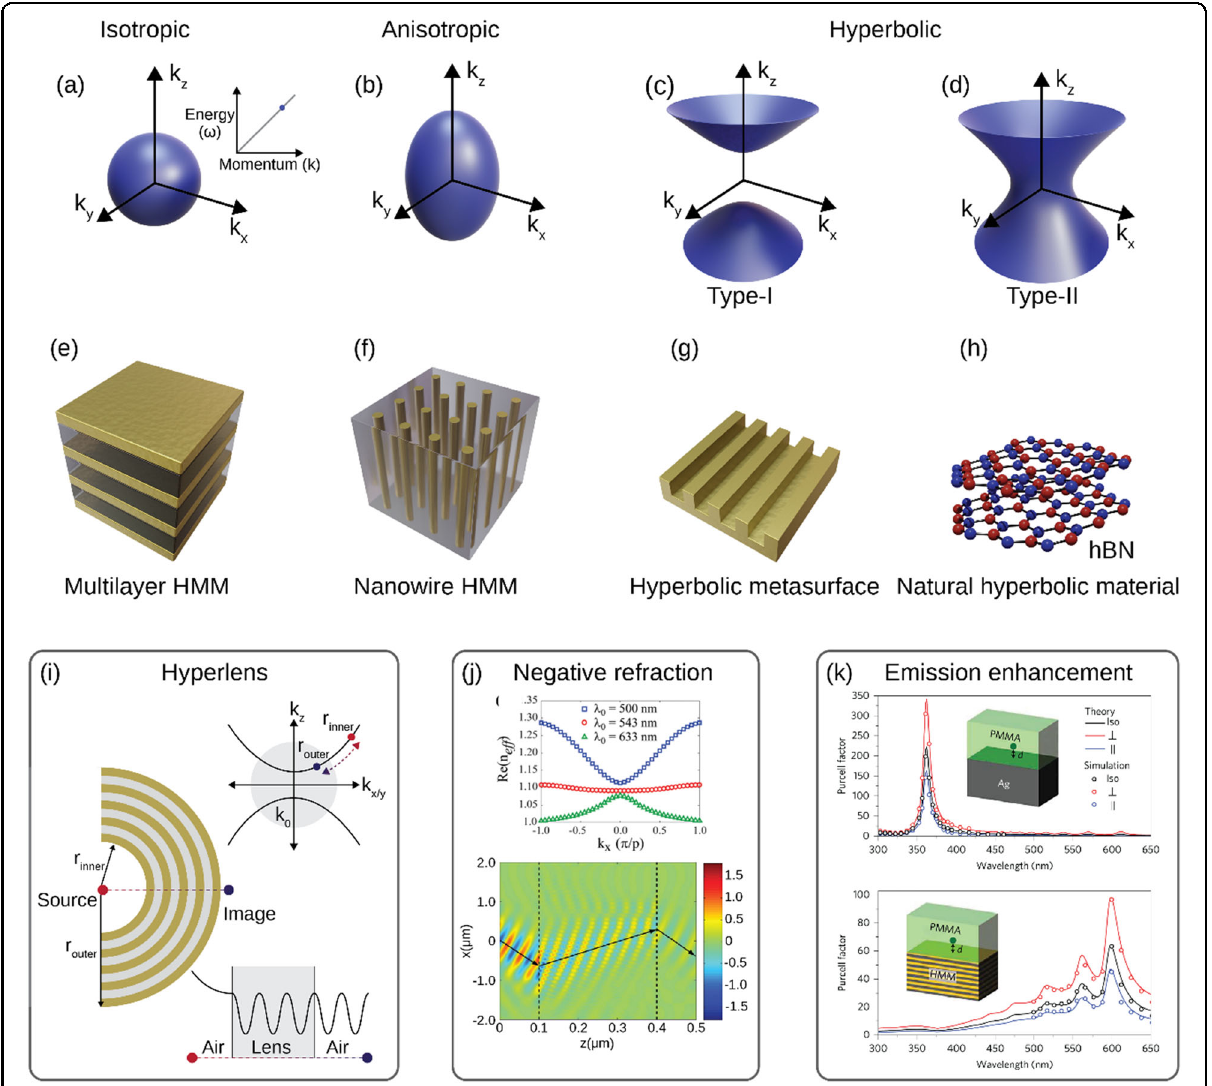
Fig. 1 Principles and applications of hyperbolic metamaterials. Isofrequency contour for a isotropic, b anisotropic media, and c Type-I and d Type-II hyperbolic materials. Different hyperbolic material designs: e multilayer hyperbolic metamaterial (HMM), f nanowire HMM, g hyperbolic metasurface, and h natural hyperbolic material. Different applications of HMMs: i a HMM hyperlens, j negative refraction in a plasmonic grating HMS, and k spontaneous emission enhancement above a silver surface (top) and a HMM (bottom). i , j , and k are adapted from refs. 3,13 , and 16 ,